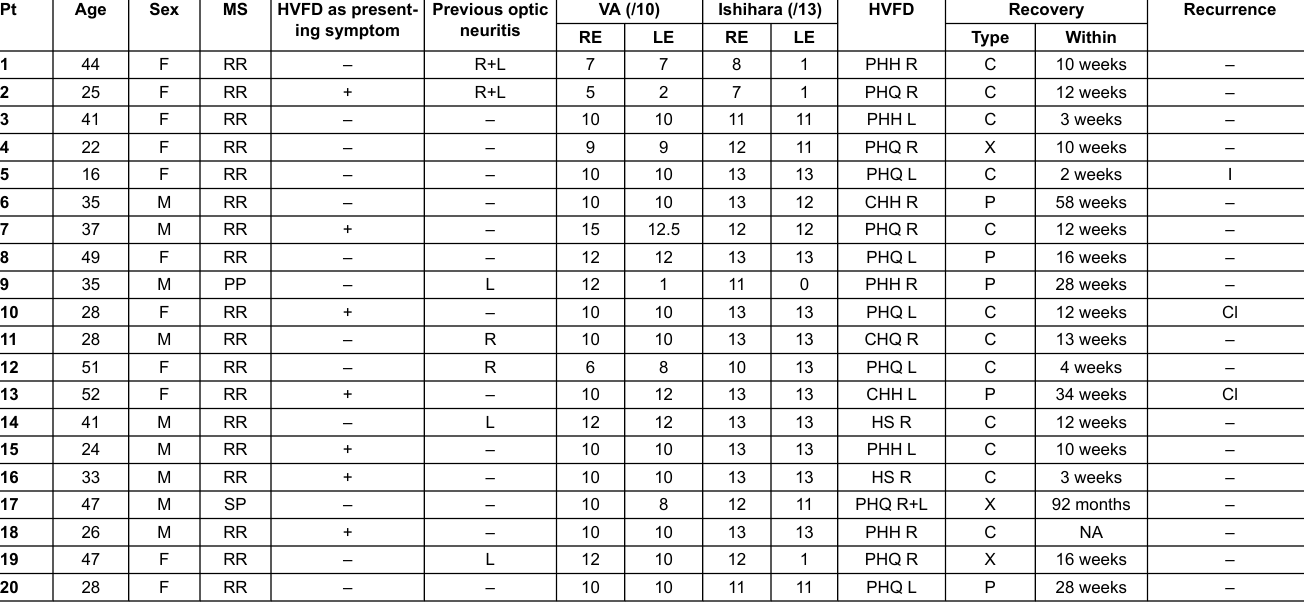
Table 1: Demographics of multiple sclerosis (MS) patients with homonymous visual field defects (HVFD). Pt Age